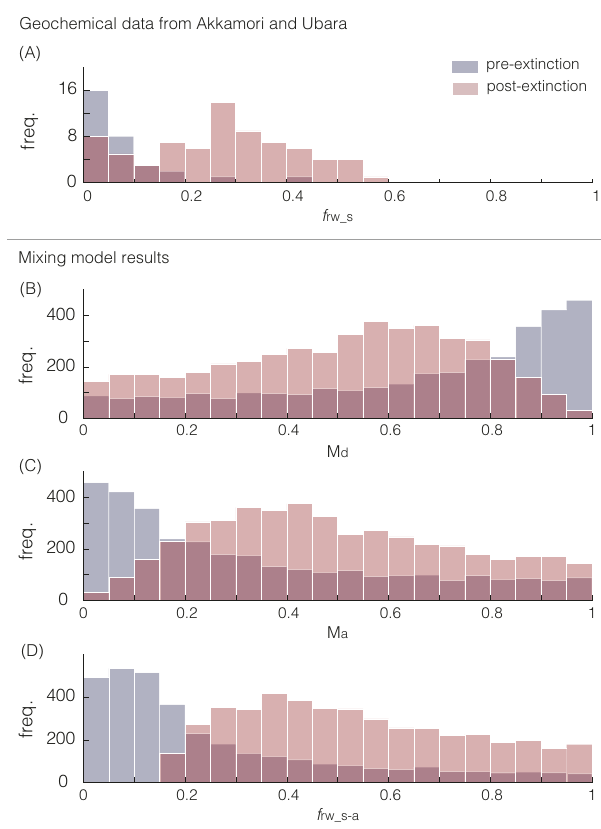
Fig. 6 f rw_s and sediment mixing model results. A Combined f rw_s from Akkamori and Ubara; B – D fi ltered mixing model results consistent with the f rw_s shift across the event; B detrital mass fraction, M d ; C authigenic mass fraction, M a ; D f rw_s-a